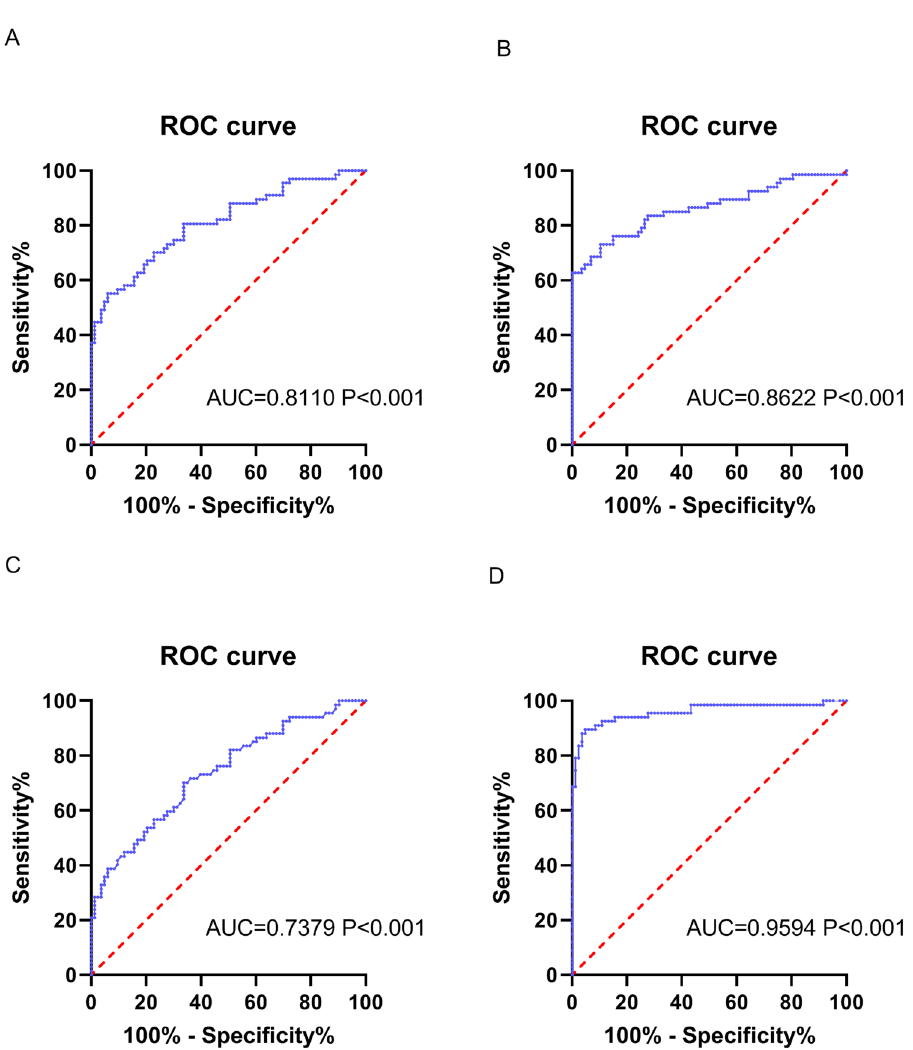
Figure 3. Predictability of LncRNA NNT-AS1, CRP and PCT on RMPP. (A) ROC curve analyzed that the AUC of LncRNA NNT-AS1 prediction on RMPP was 0.8110. (B) ROC curve analyzed that the AUC of CRP prediction on RMPP was 0.8622. (C) ROC curve analyzed that the AUC of PCT prediction on RMPP was 0.7379. (D) ROC curve analyzed that the AUC of the combined prediction of LncRNA NNT-AS1, CRP and PCT on RMPP was 0.9594 (P <